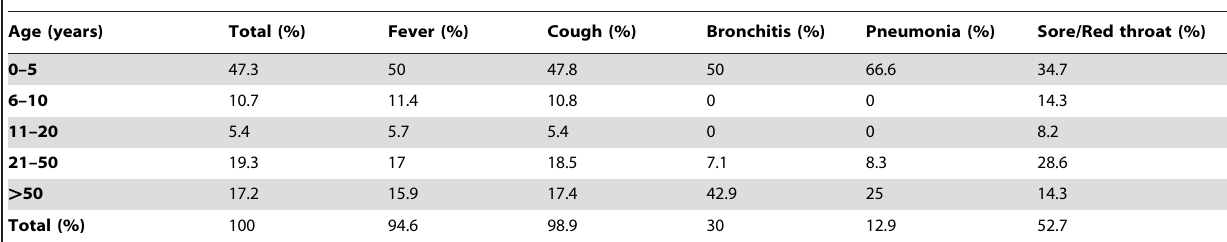
Table 1. Clinical